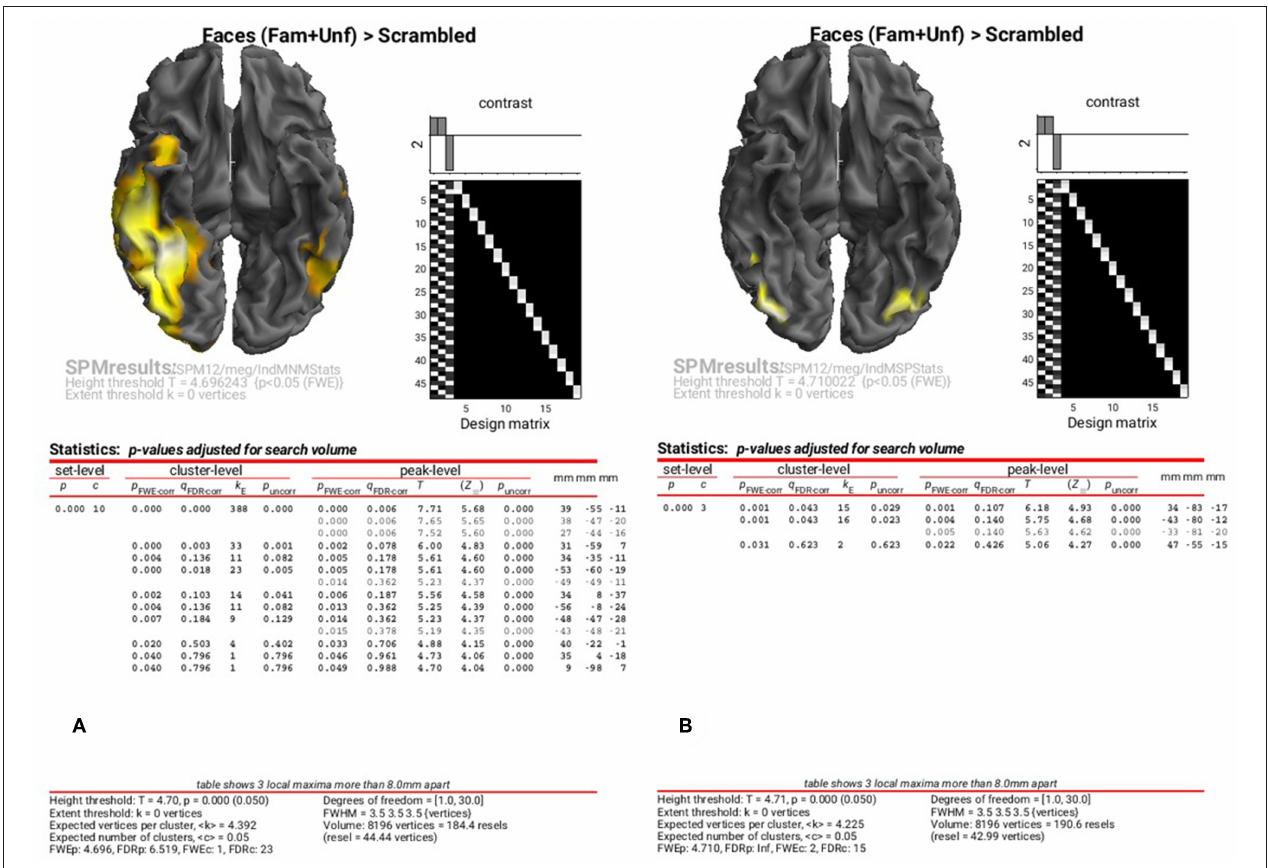
FIGURE 8 | Group SPM for Faces vs. Scrambled power on cortical mesh between 10 and 20Hz and 100 and 250ms across all 16 subjects at p < 0.05 FWE corrected for MNM (A) and MSP (B) .